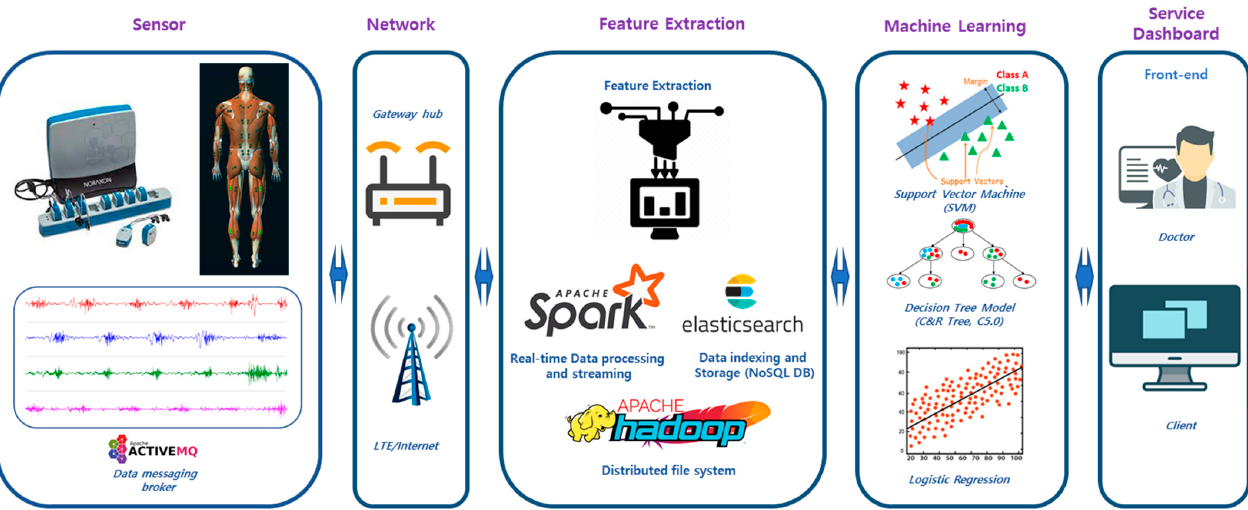
Figure 1. Overview of the EMG-based disease prediction system. The EMG data acquisition system consisted of a wearable EMG sensor. This system feeds the EMG data to a cloud server using Wi-Fi or LTE networks. In the cloud server, Elasticsearch indexes the data and acts as the No-SQL database. Spark performs feature extraction, feature selection, and machine-learning-based prediction and provides a query service for front-end service applications. This ambulatory system was developed to identify the changes in myoelectric features due to ischemic stroke or other disabilities and generate health advice to assist patients and hospitals.